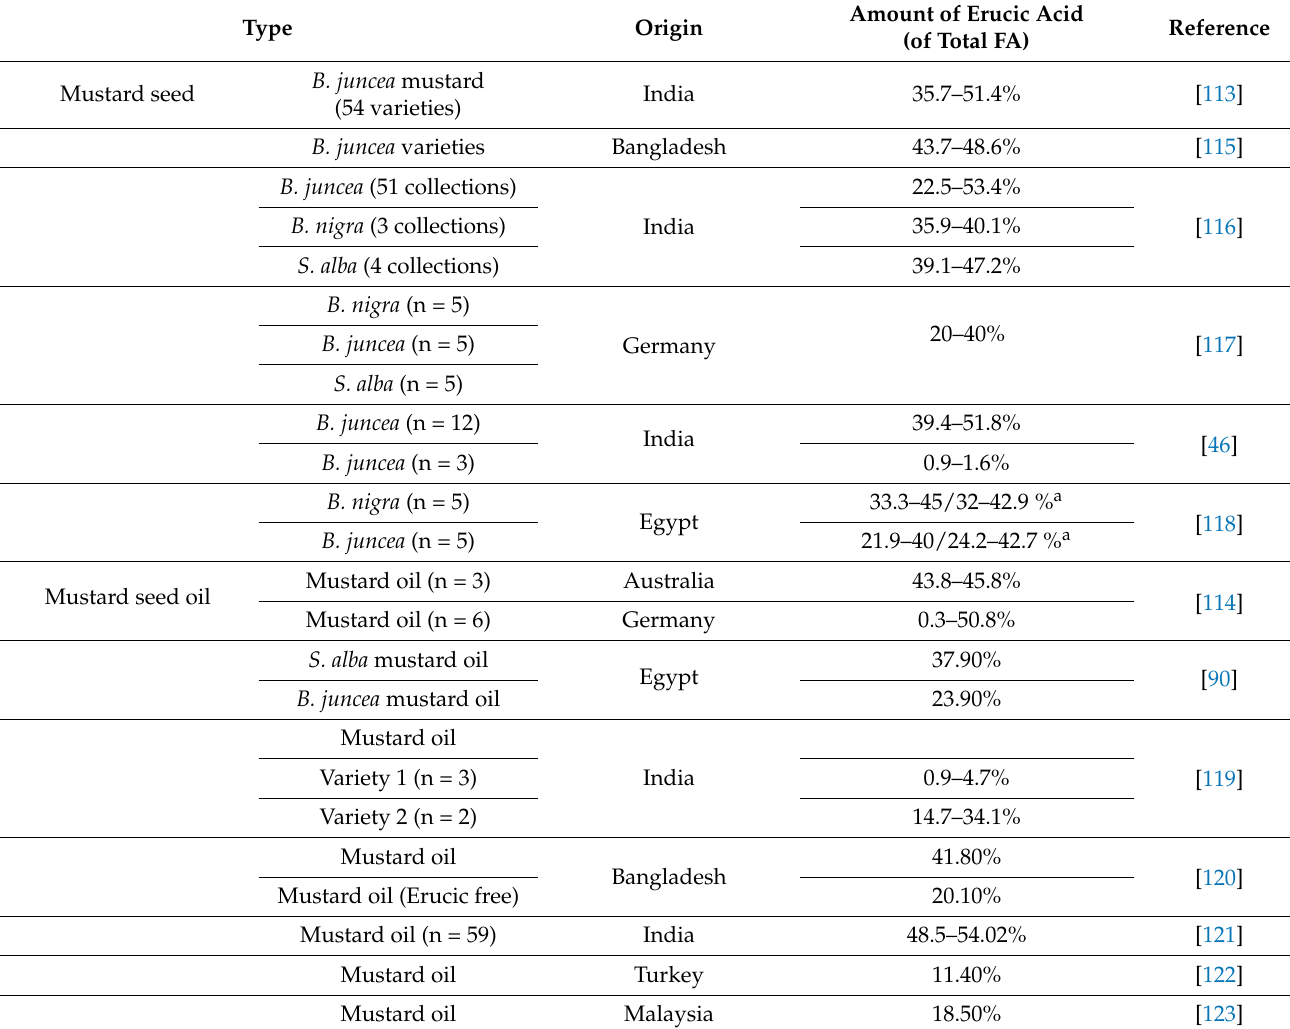
Table 4. Erucic acid concentration in mustard